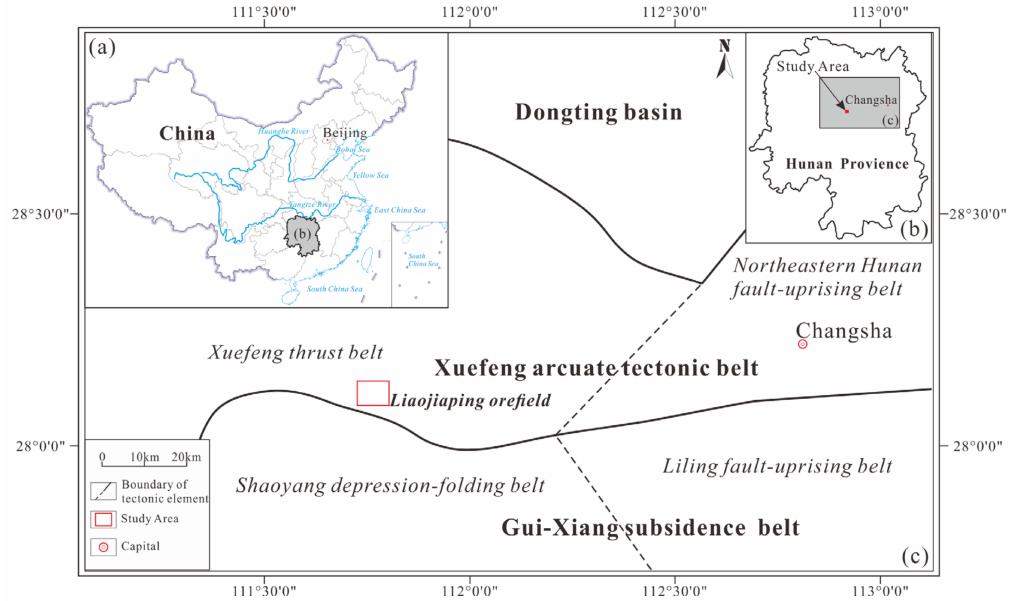
Figure 1. Location of the Hunan province in China ( a ), the study area in Hunan province ( b ) and the geological settings of the Liaojiaping Orefield ( c